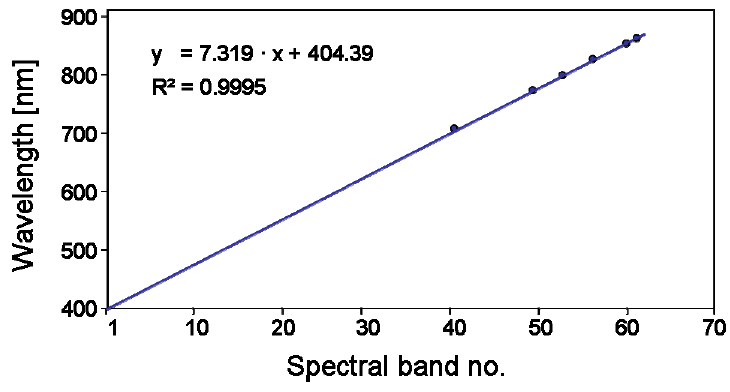
Figure 8. Wavelength calibration using emission lines of a krypton